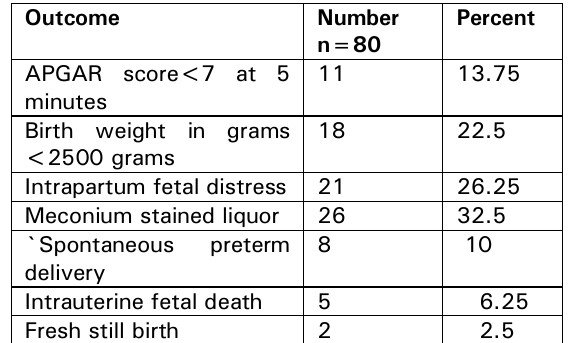
Table 5 : Neonatal